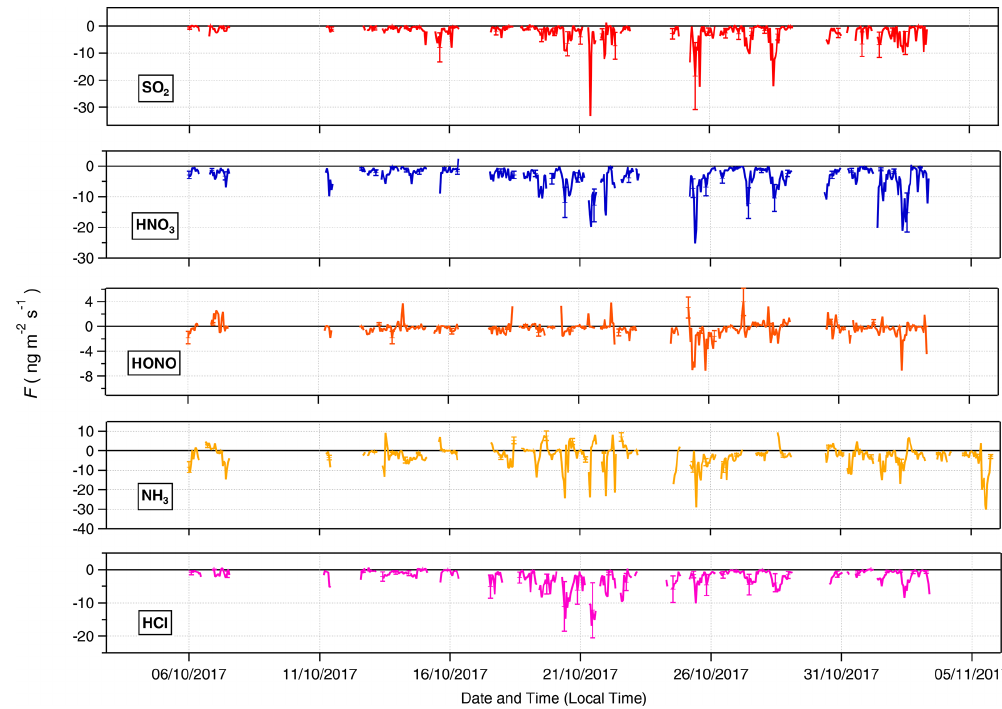
Figure 7. Time series of filtered fluxes for the inorganic trace gas species measured during the